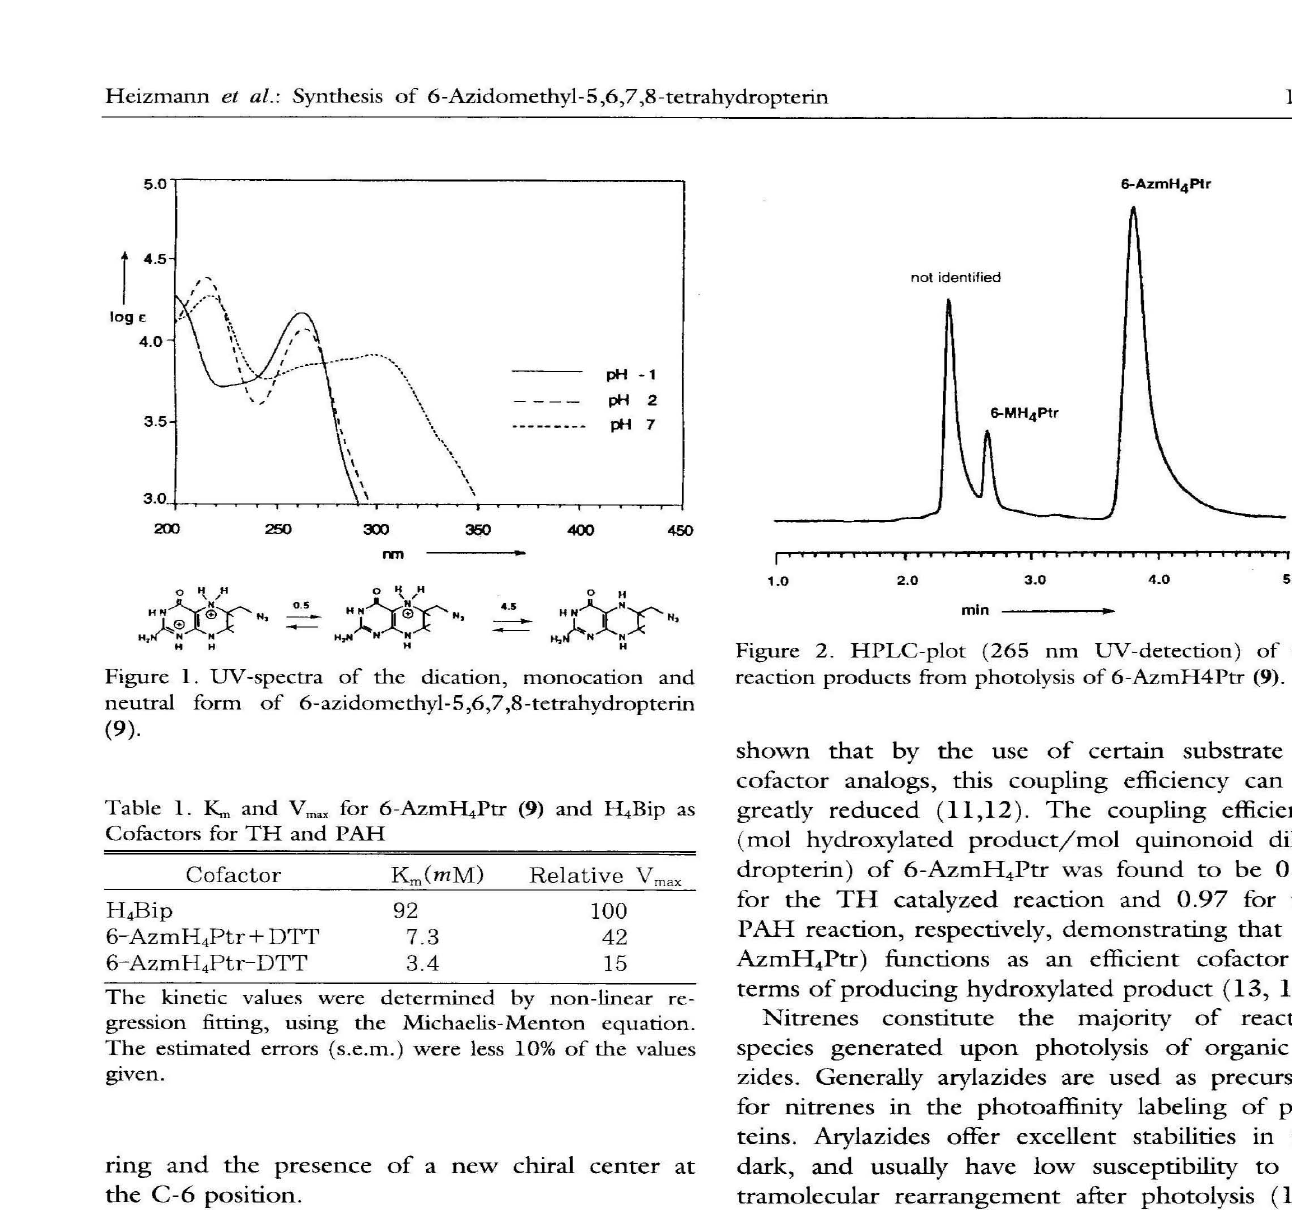
Figure 2 . HPLC-plot (265 nm UV-detection) of the reaction products from photolysis of 6-AzmH4Ptr